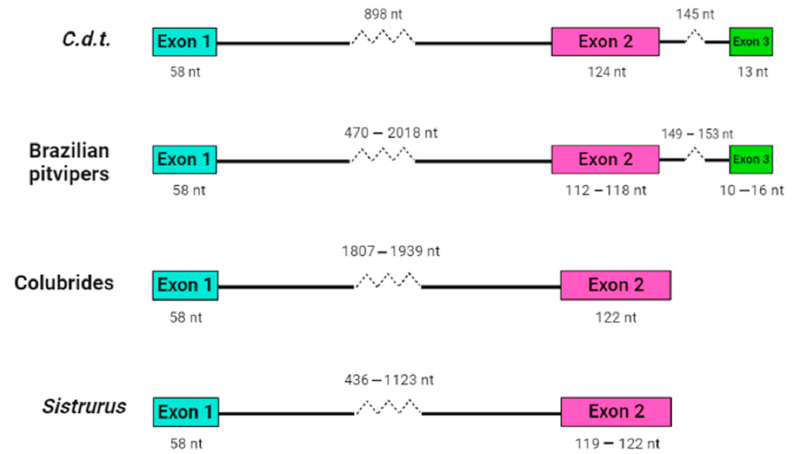
Figure 1. Structural organization of snake β -defensin genes. Crotamine sequence ( C.d.t. , GenBank AF223947 [149]), crotamine-like sequences of Brazilian pit vipers [146], β -de- fensin-like sequences of Colubrides ( Phalotris mertensi , Thamnodynastes hypoconia , and T. strigatus [145], and crotamine-like sequences of S. miliarius (GenBank MT024631-024638). Only exons and introns are represented.